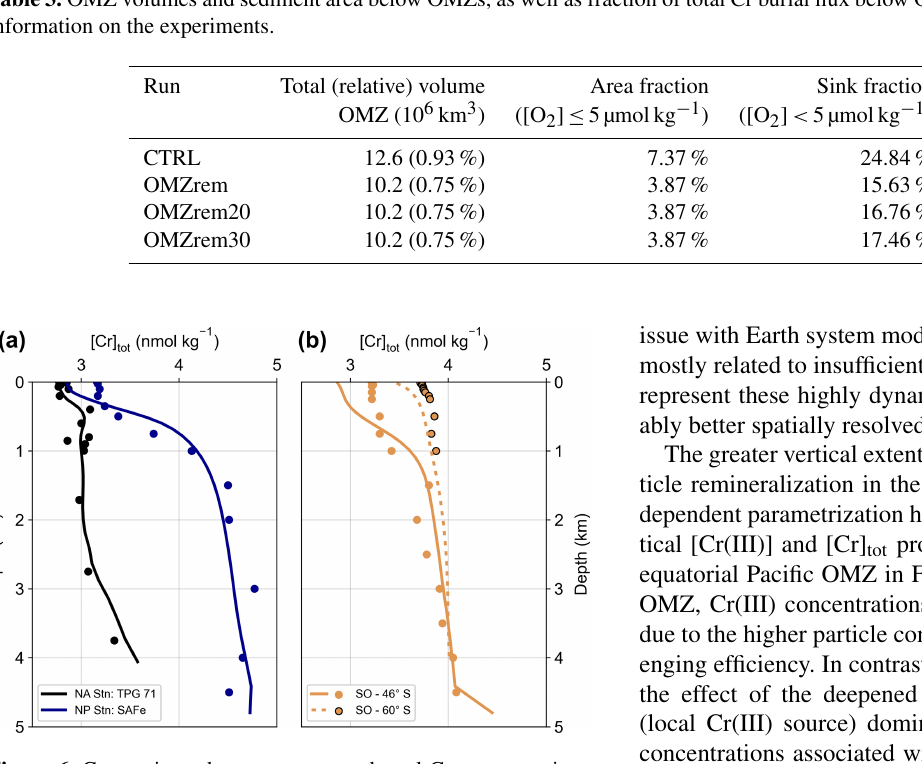
Figure 6. Comparisons between measured total Cr concentrations of four seawater stations (circles) and simulated values of the con- trol run at the closest model grid cells (lines). North Atlantic station TPG 71 (Jeandel and Minster, 1987), North Pacific station SAFe (Moos and Boyle, 2019), and Southern Ocean stations at 46 ◦ S (composite of IN2018V04 – Stn. PS2, Janssen et al., 2021, and ACE Leg2 – Stn. 8, Rickli et al., 2019) and 60 ◦ S (ACE Leg2 – Stn. 10, Rickli et al.,